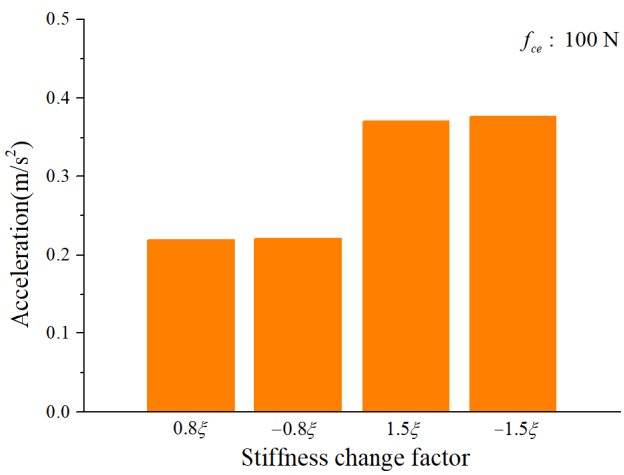
Figure 12. Acceleration RMS.